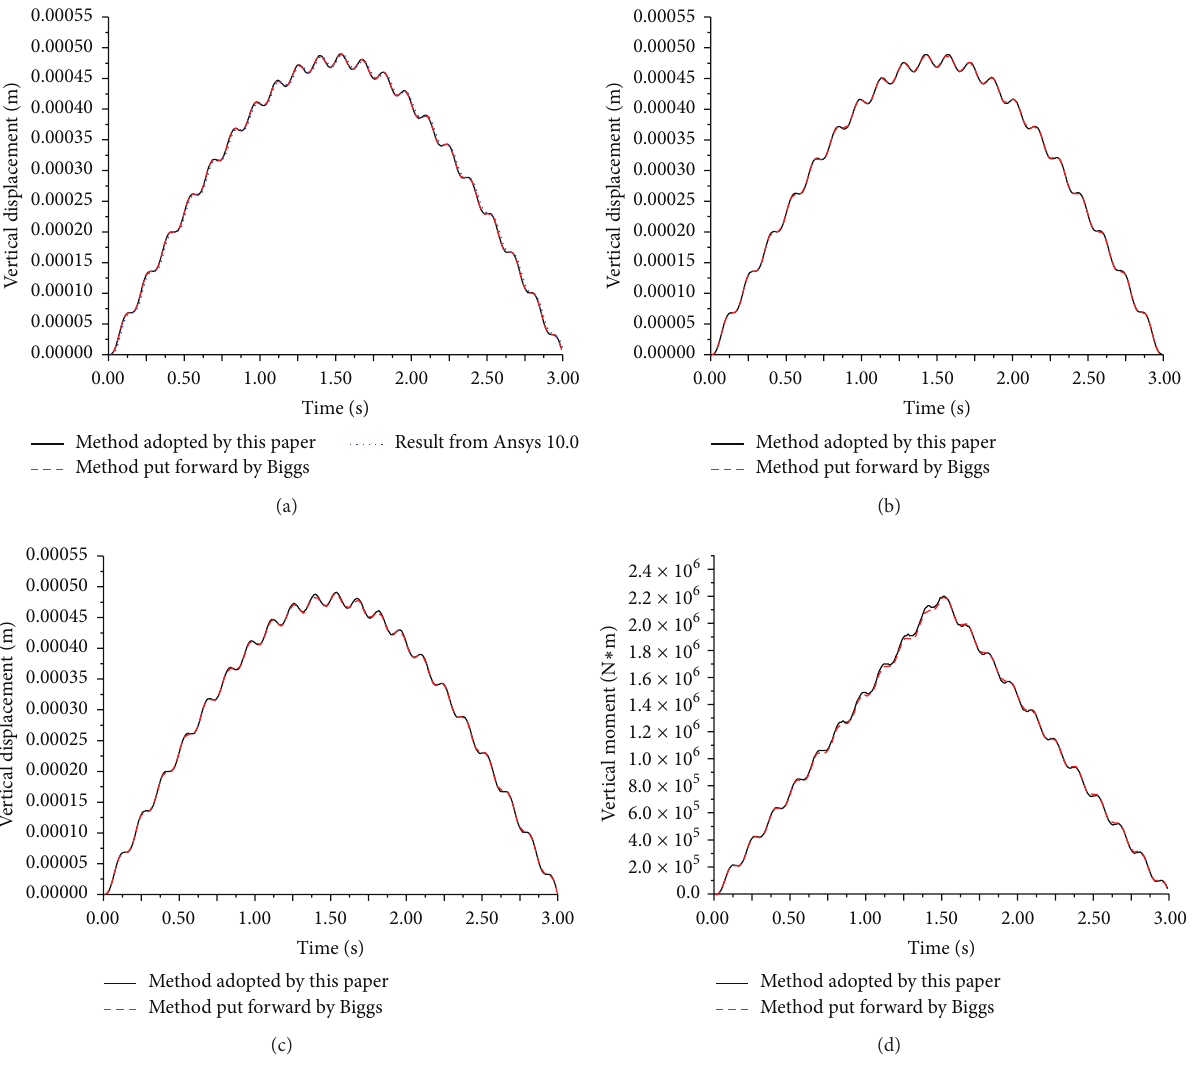
Figure 4: Dynamic response of a simply supported beam at mid-span: (a) vertical displacement under the action of a moving constant load; (b) vertical displacement under the action of a moving mass; (c) vertical displacement under the action of a moving sprung mass; (d) vertical moment under the action of a moving sprung